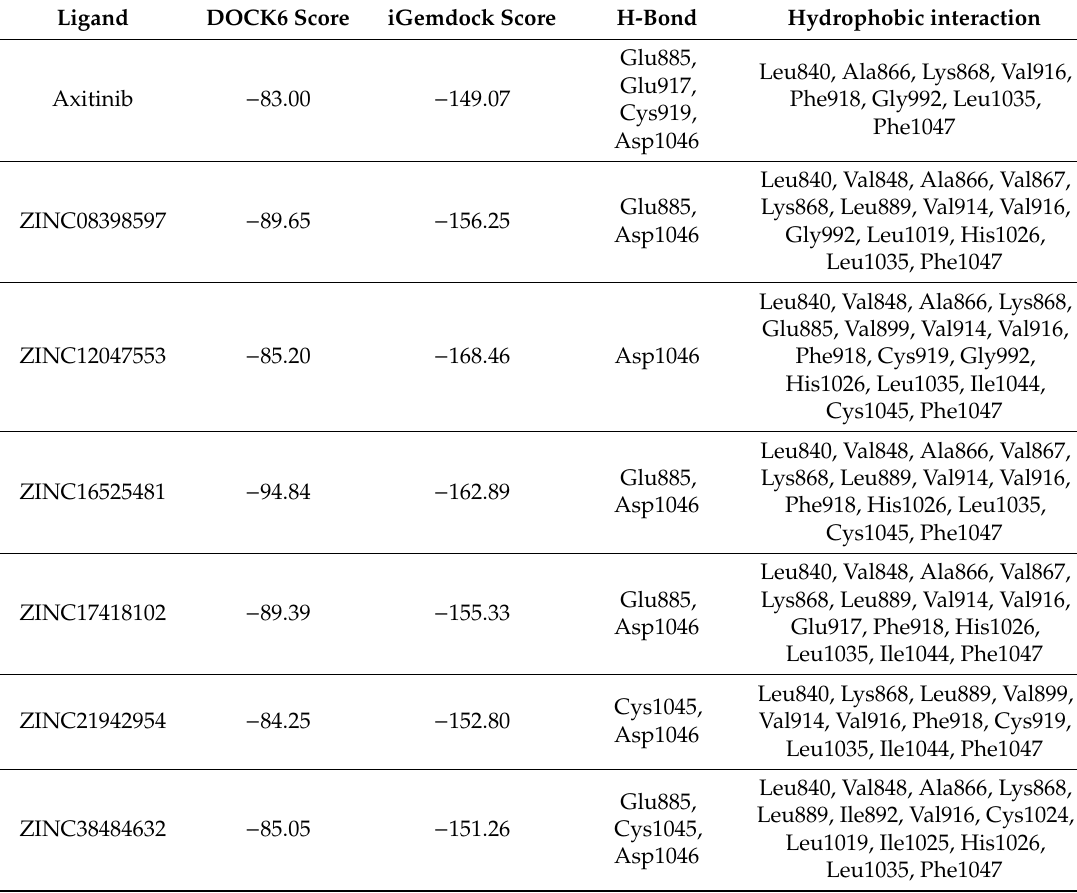
Table 2. VEGFR2-ligand interactions recorded during docking.